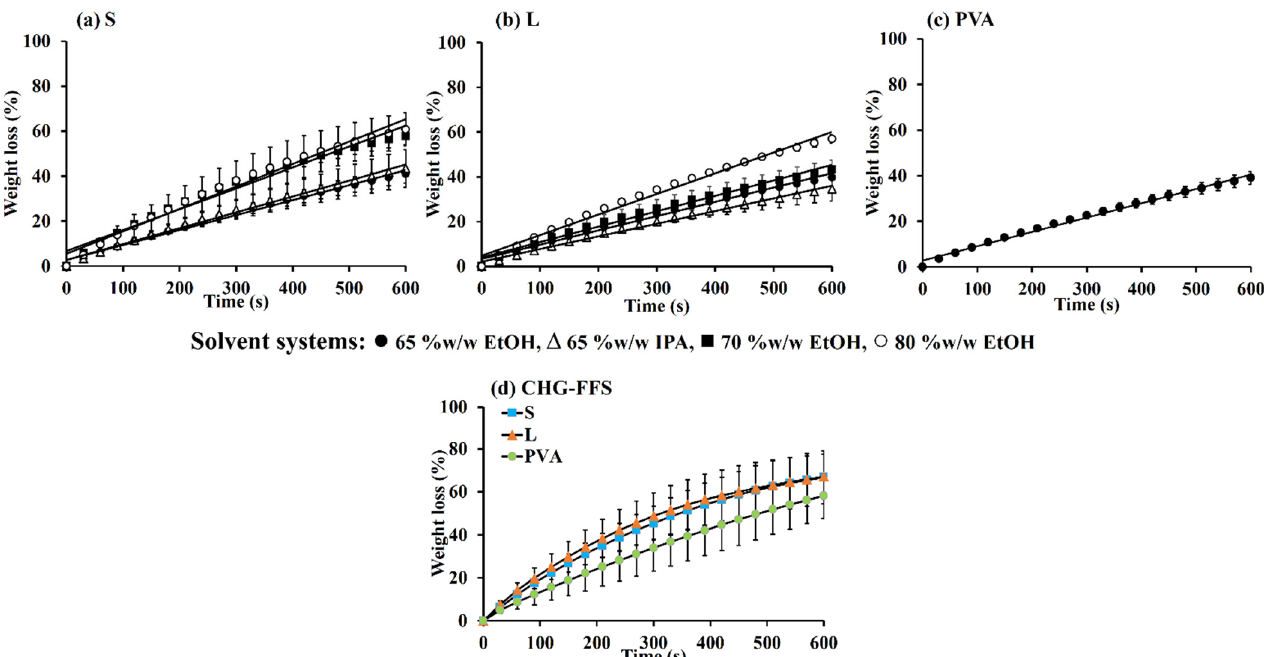
Figure 1. The percentage of the weight loss presented as the evaporation rates of the FFS at different types, and concentrations of the solvent systems at room temperature of 25–28 °C. The experiment was repeated three times, and the results were presented as the mean ± SD.